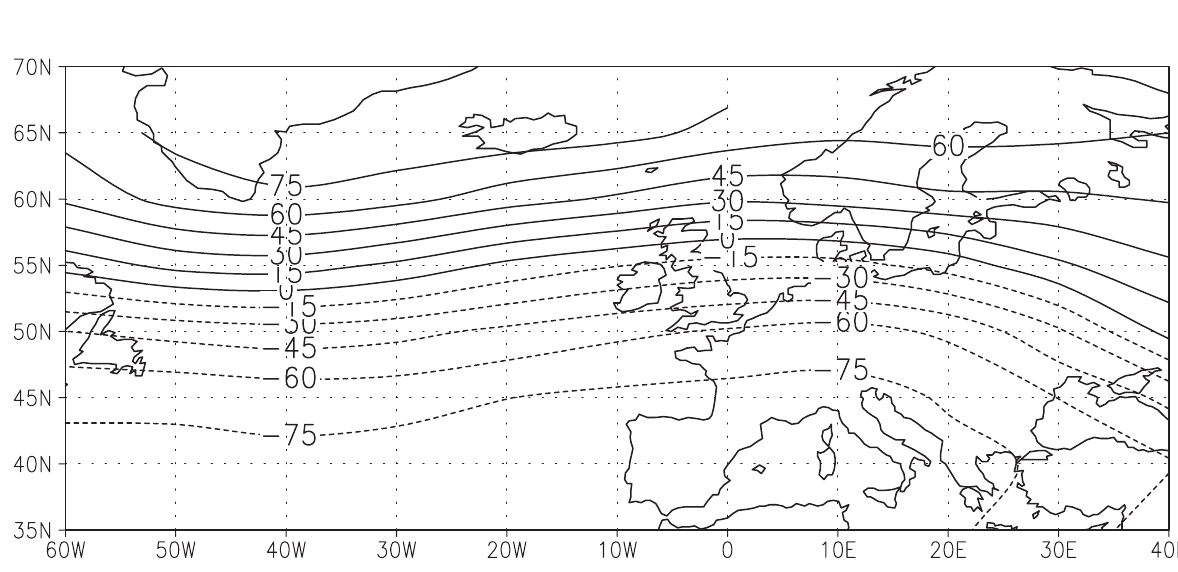
Fig. 3. First EOF pattern (explaining 43% of the total variance) of gridded observations of JFM seasonal mean Atlantic/European MSLP.